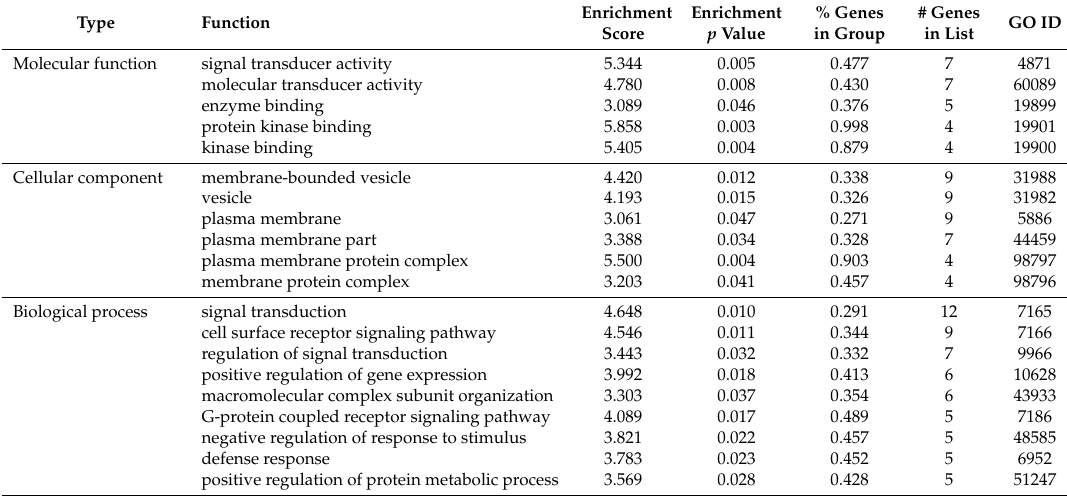
Table 7. Gene ontology (GO) categories of CNAs (>100 kb and occurring in two or more than two patients with